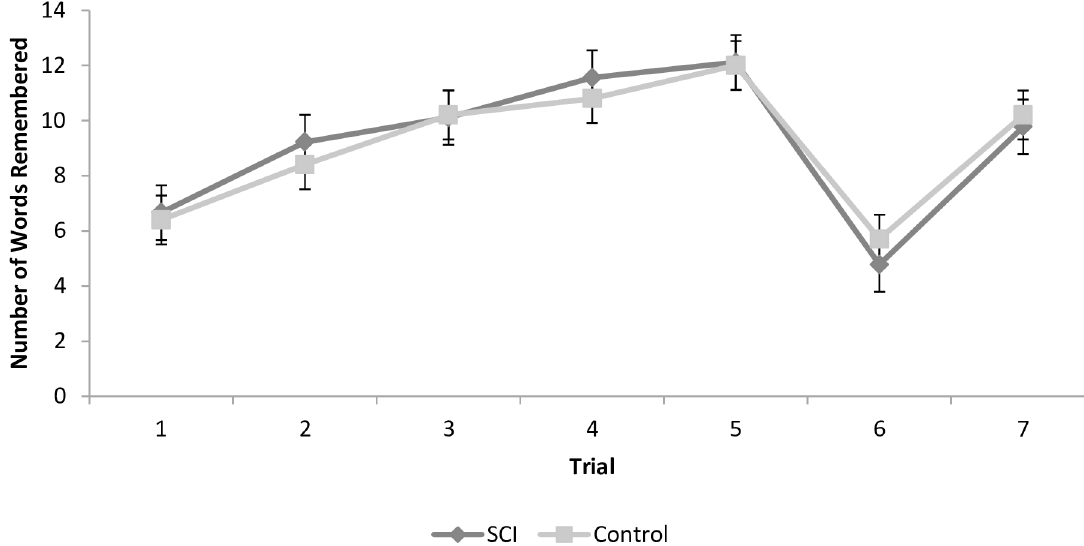
Fig 3. Rey Auditory Verbal Learning Task (RAVLT) performance (mean and SEM) in the spinal cord injury and control groups.